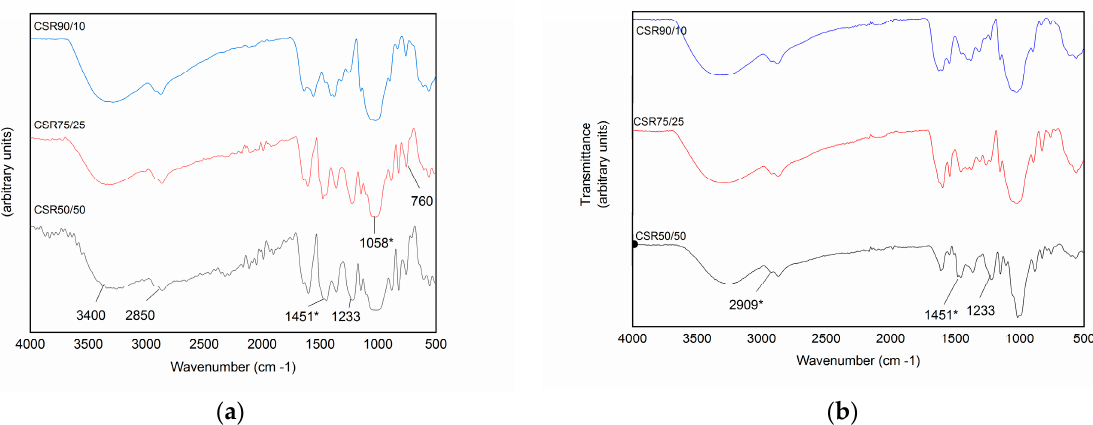
Figure 2. FTIR Spectrum comparison: ( a ) CS/R aerogel after processing; ( b ) CS/R aerogel after